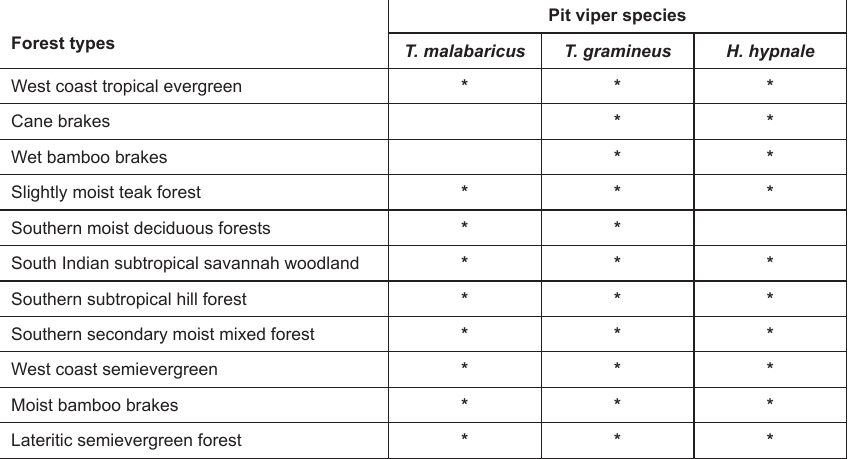
Figure 2. Graph showing mean ± SD, min and max value of altitude (in m) at which the pit viper species were observed in Goa